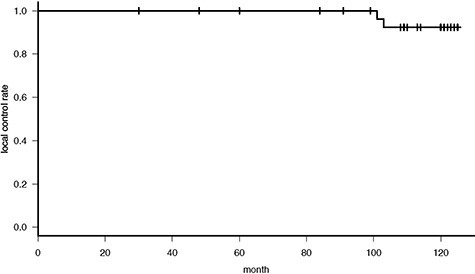
Local control rate.